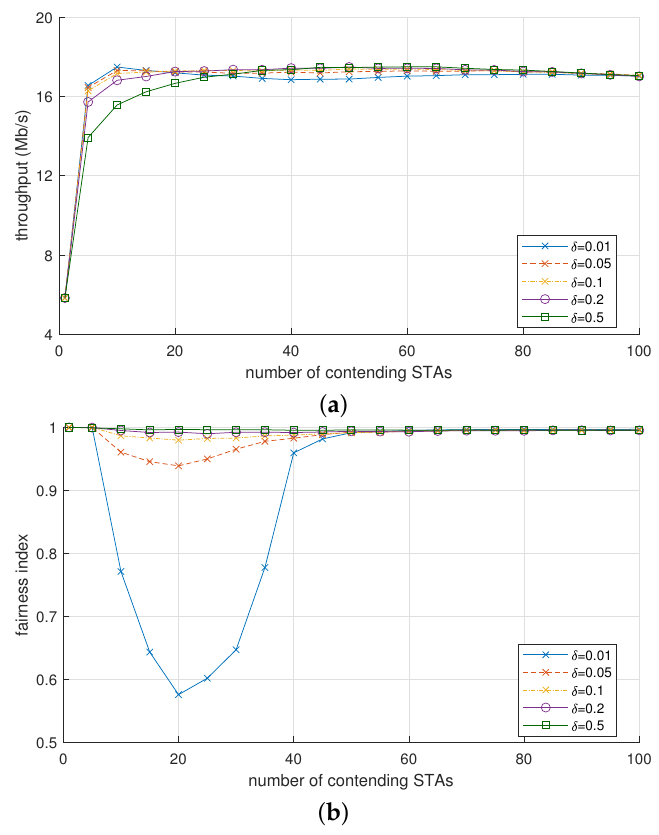
Figure 6. Effect of δ in OBO_CTRL on ( a ) throughput and ( b )